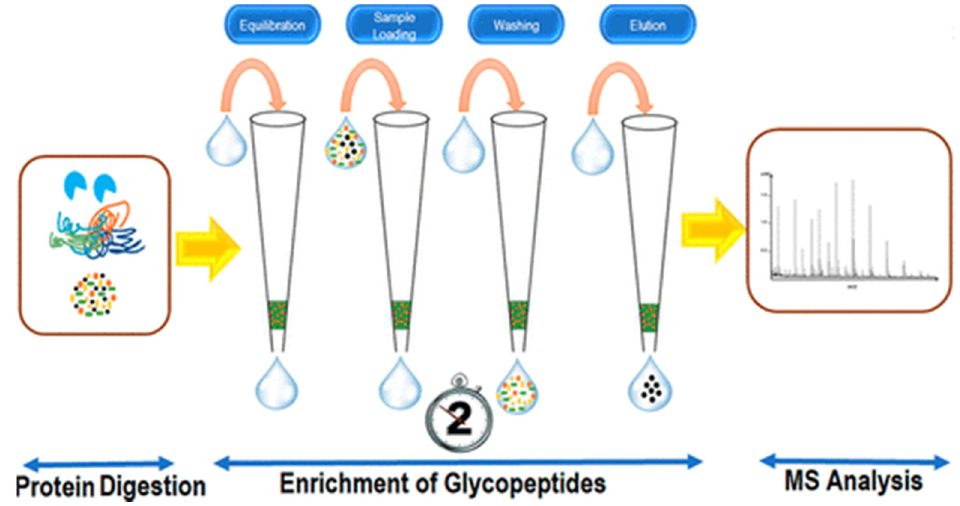
Figure 2. A tip-based strategy using a piperazine-modified polymeric monolithic tip for fast separation (2 min) of glycopeptides and glycans under optimized conditions with 20 cycles per step of loading, incubation, washing, and elution, followed by MALDI-MS analysis. Reprinted with permission from reference [74].